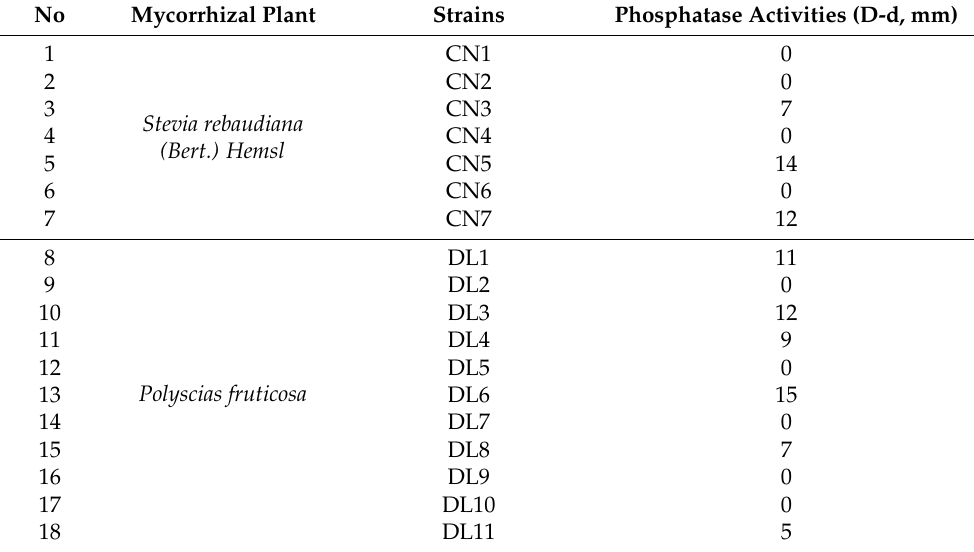
Table 2. Evaluation of phosphatase enzyme activity of fungal